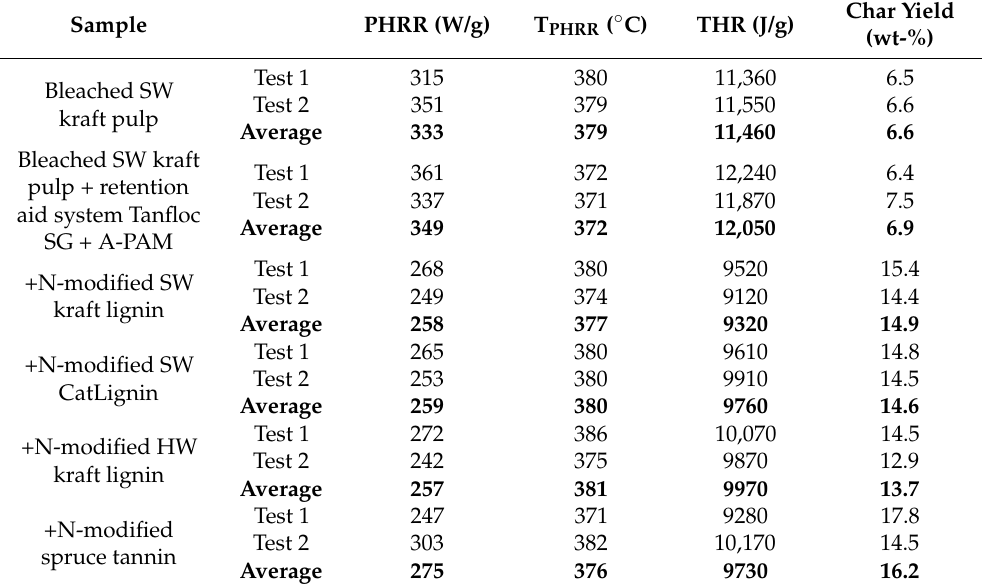
Table 5. MCC test results of mixtures with kraft cellulose fibres and Tanfloc SG 2.5% + 0.45%